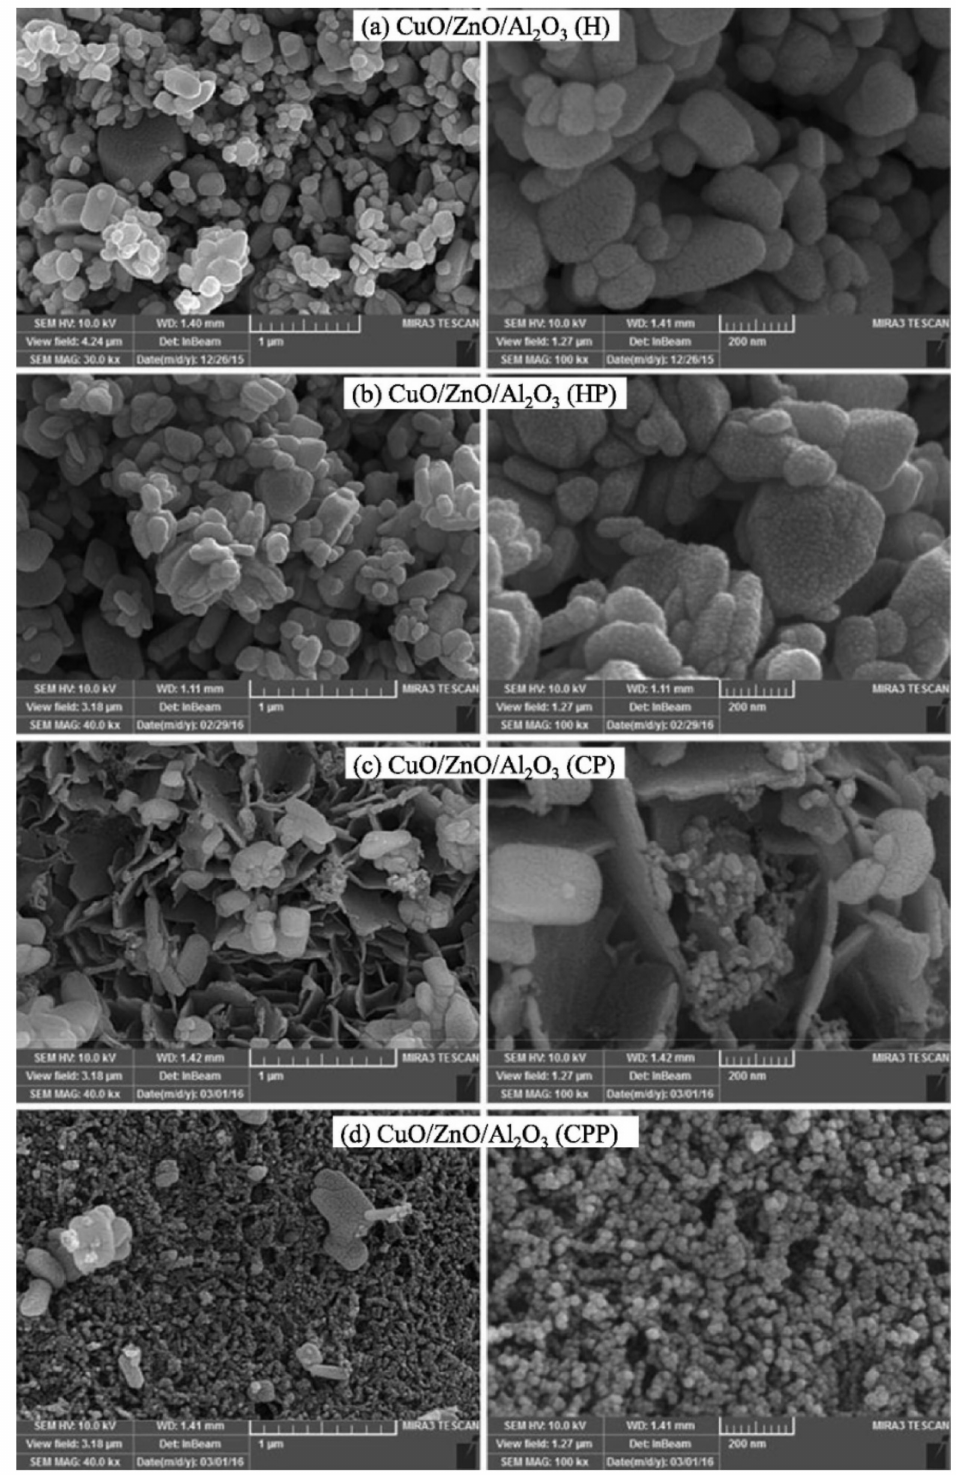
Figure 9. FESEM images of synthesized catalysts: ( a ) CuO/ZnO/Al 2 O 3 (Hydrothermal synthesis, H), ( b ) CuO/ZnO/Al 2 O 3 (Plasma assisted Hydrothermal synthesis, HP), ( c ) CuO/ZnO/Al 2 O 3 (Coprecipitation method, CP), and ( d ) CuO/ZnO/Al 2 O 3 (Plasma-assisted Coprecipitation method, CPP). (Adapted from [31], copyright 2017,